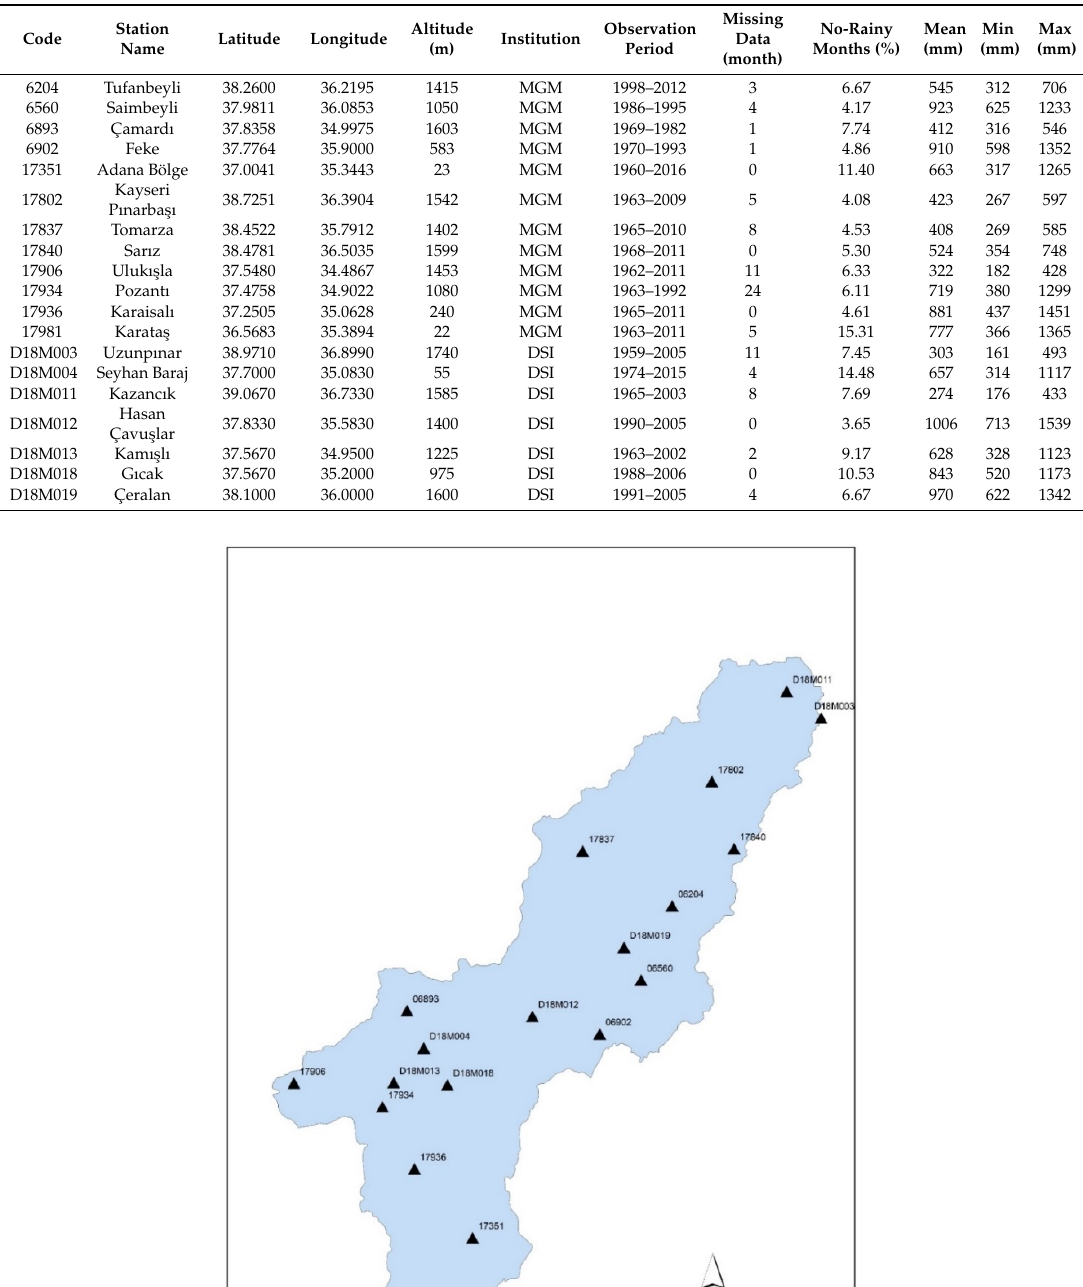
Table 1. Meteorological stations in the Seyhan River basin.